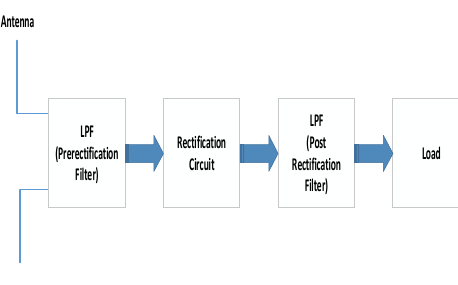
Figure 7: Rectenna equivalent